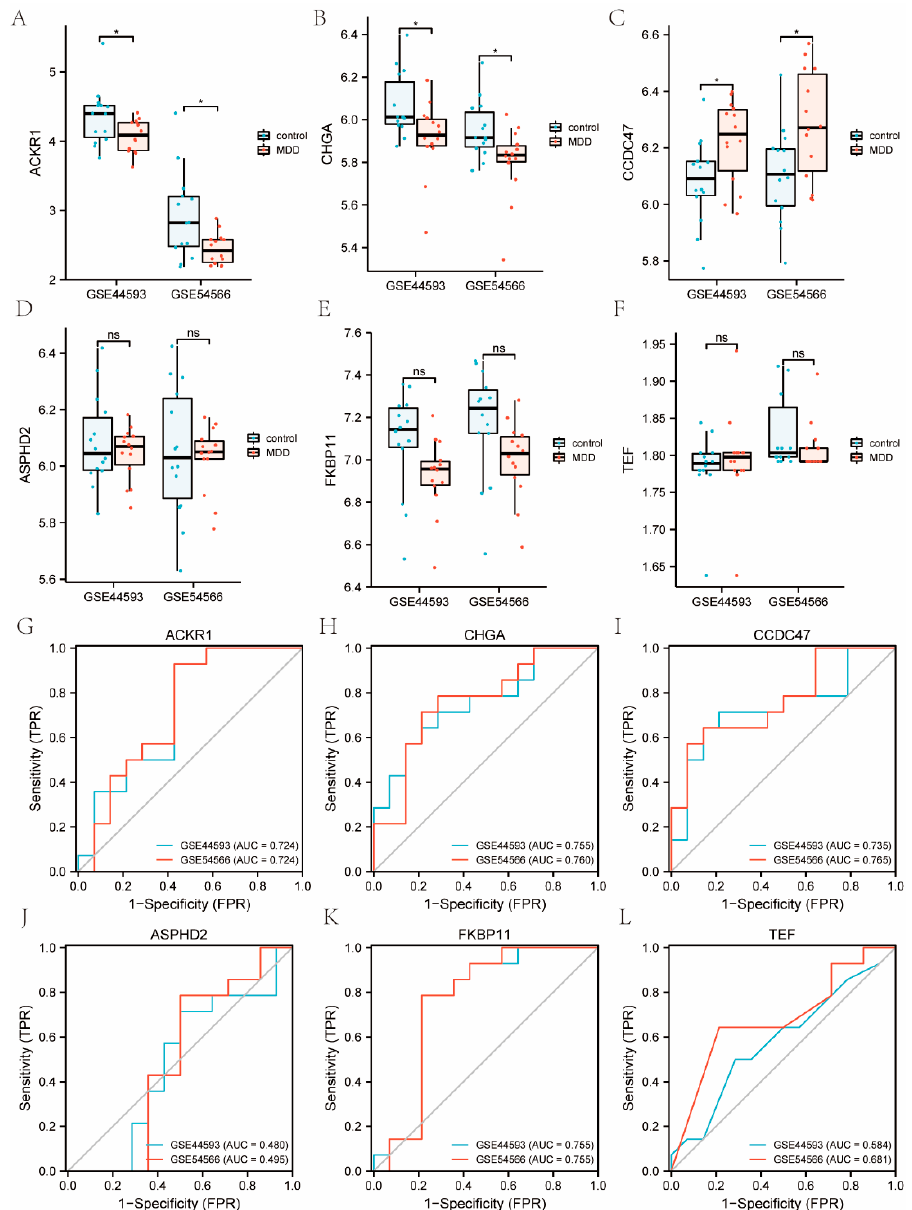
Figure 9. Expression analysis and the ROC curve predicted diagnostic efficacy of TRRDEGs molecules in the GSE44593 and GSE54566 datasets. ( A – F ) Group comparison of TRRDEGs molecules. ( G – L ) ROC curve diagnostic efficacy of TRRDEGs molecules. * represents p < 0.05.